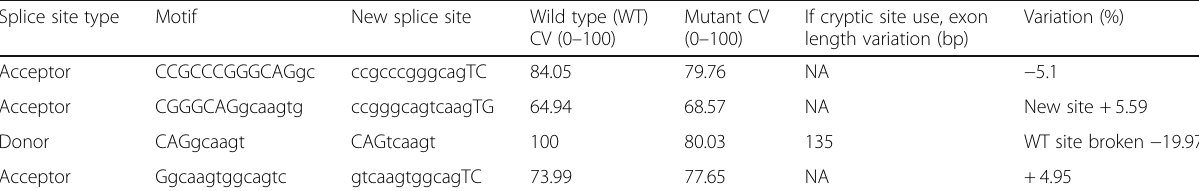
Table 2 Data findings: CVs and percentage variation of wild type and mutant sequences in intron 11 of IDUA gene (http:// www.umd.be/HSF/)